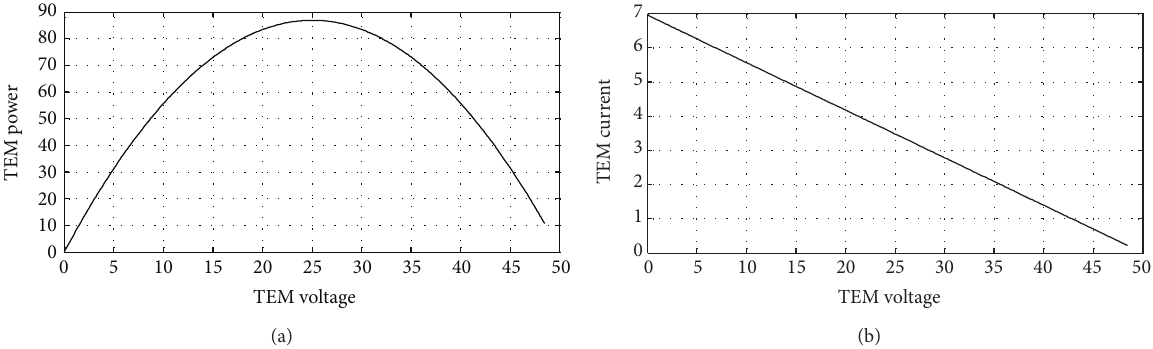
Figure 8: TEM characteristics at a temperature variation from 25 ∘ C to 85 ∘ C: (a) 𝑃 - 𝑉 characteristic and (b) 𝐼 - 𝑉 characteristic.